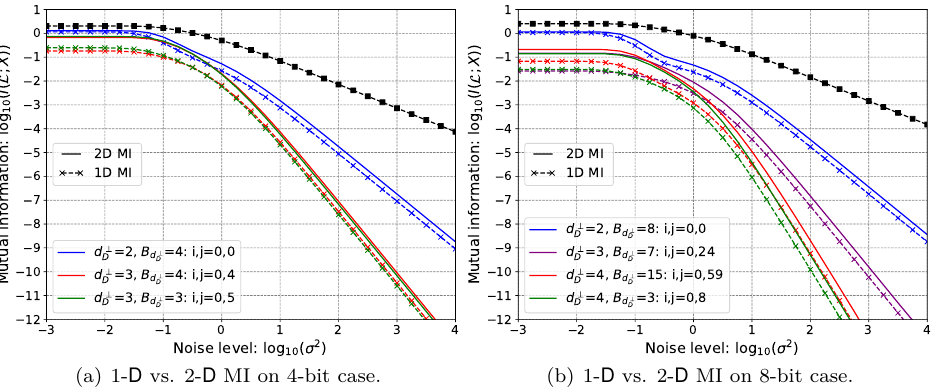
and/or B 0 . D 2 d ⊥ D 2